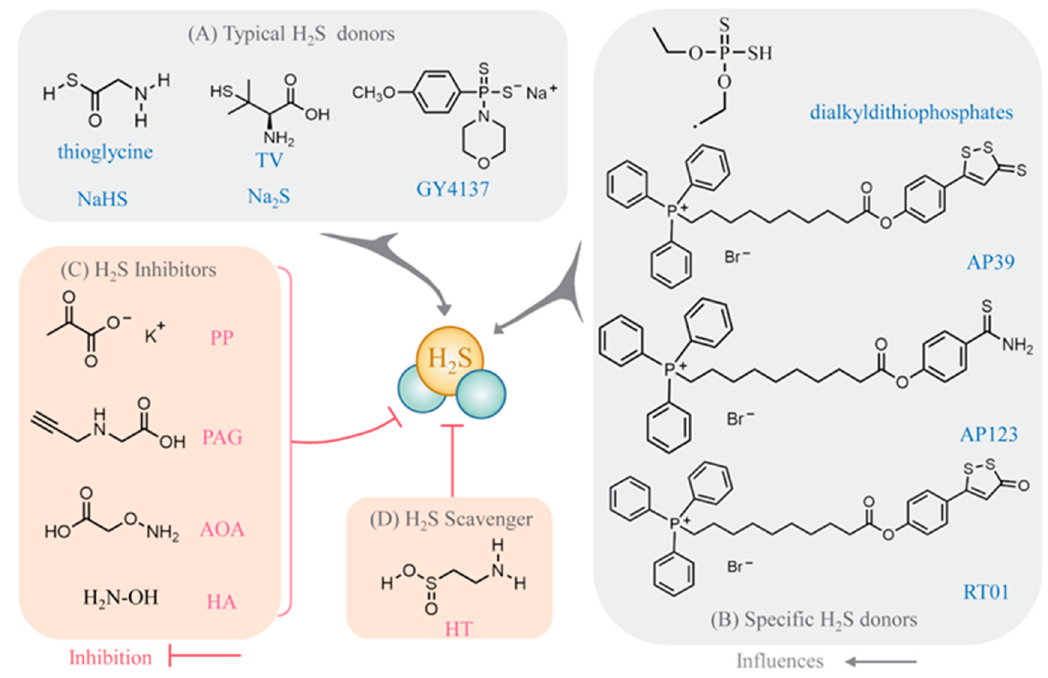
Figure 3. The donors of H 2 S (inhibitor (scavenger)): ( A ) Traditional H 2 S donor; ( B ) special H 2 S donor; ( C ) inhibitor of H 2 S; ( D ) scavenging of H 2 S. Note: AP39 (anethole dithiolethione/(10-oxo-10-(4-(3- thioxo-3H-1,2-dithiol-5yl)phenoxy)decyl) triphenylphosphonium bromide), AP123 (hydroxythiobenzamide), AOA (aminooxyacetic acid), GY4137 (morpholin-4-ium 4-methoxyphenyl (morpholino) phosphinodithioate), HA (hydroxylamine), HT (hypotaurine), NaHS (sodium hydrosulfide), Na 2 S (sodium sulfide), PAG ( DL -propargylglycine), PP (potassium pyruvate), RT01 (dialkyldithiophosphates), TV ( L -thiovaline).